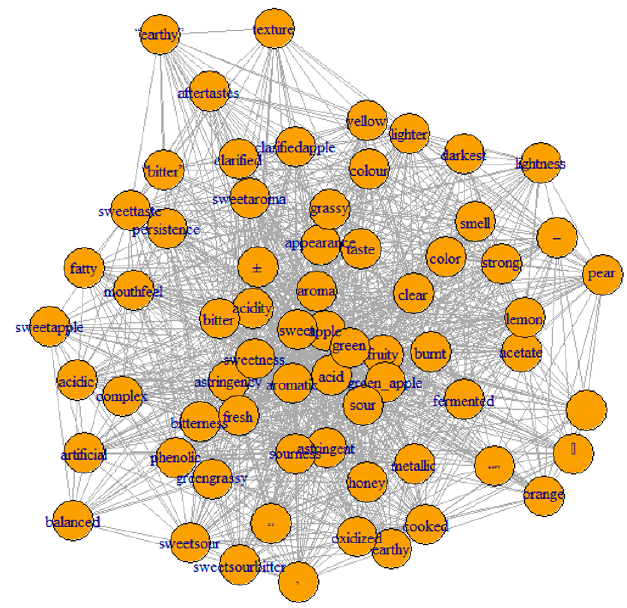
Figure 1. Network of most frequent terms based on their co-occurrence in the selected articles before the manual filtering and the normalization step.